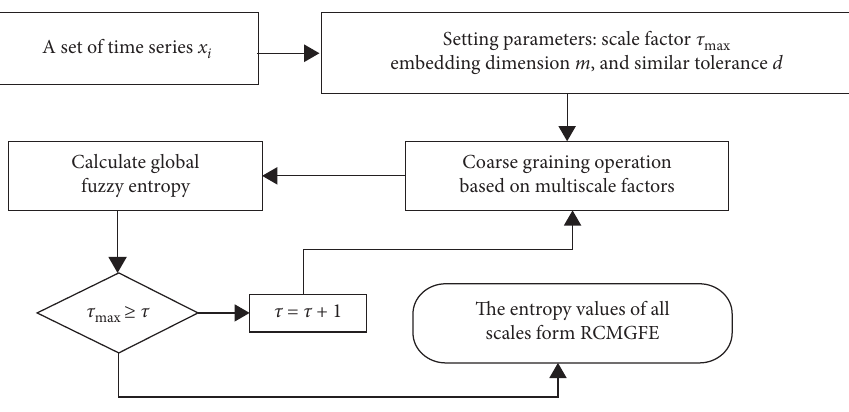
Figure 1: Calculation process of